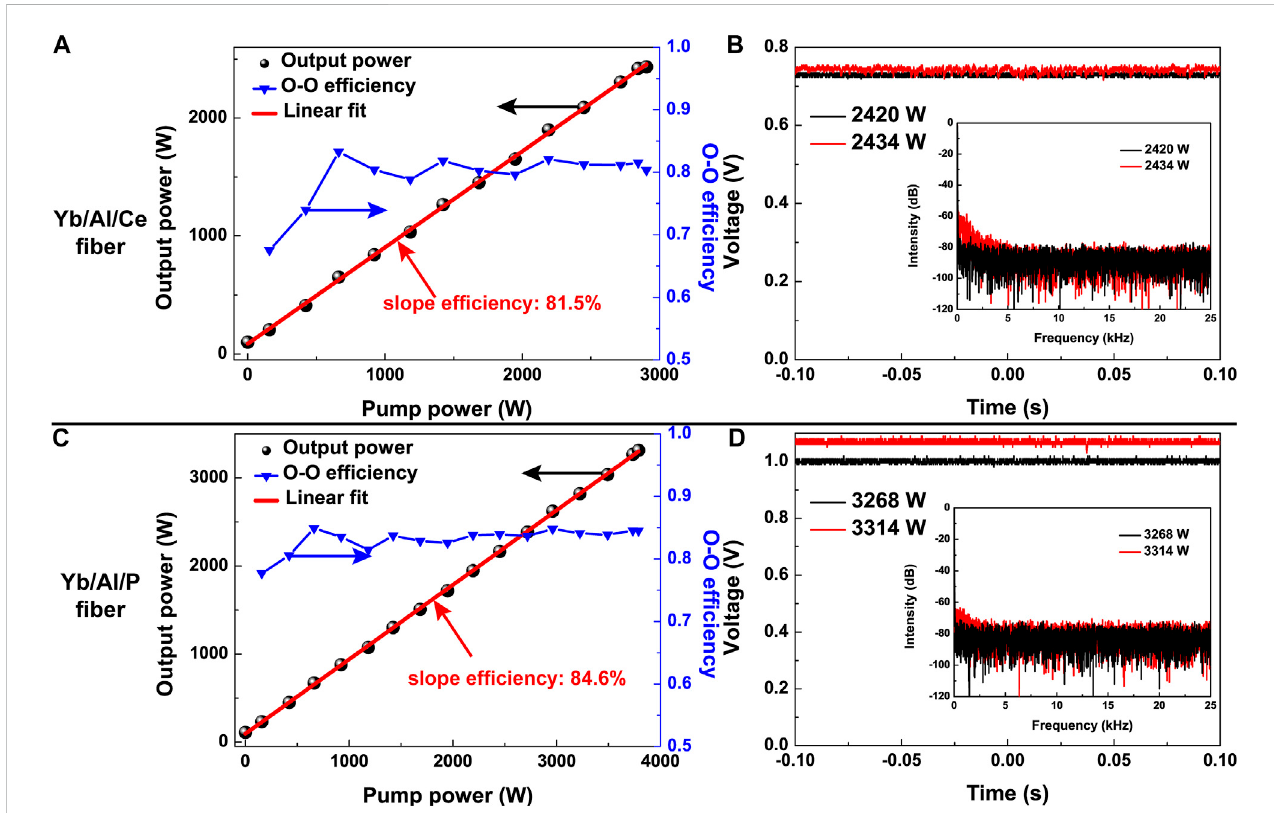
FIGURE 8 Laser performances in counter-pumped ampli fi er. Yb/Al/Ce fi ber: (A) output power and O-O ef fi ciency dependence on the pump power; (B) time- and frequency-domain signals. Yb/Al/P fi ber: (C) output power and O-O ef fi ciency dependence on the pump power; (D) time- and frequency-domain signals.